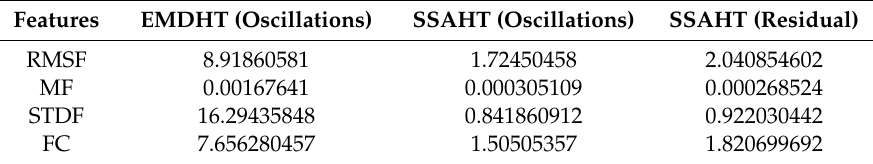
Table 3. Features frequency domain for the error indexes of rebuilt oscillations via the empirical mode decomposition Hilbert transform (EMDHT) technique and the singular spectrum analysis and Hilbert transform (SSAHT) technique. (Unit: ◦